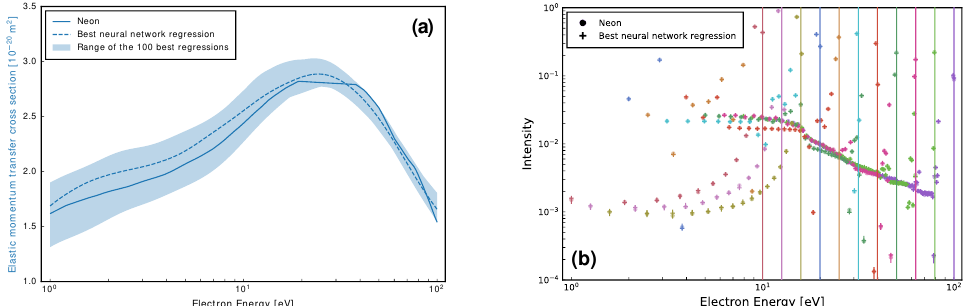
Figure 3. Neural network regression of Ne’s elastic MTCS [90], ( a ), and the corresponding agreement, ( b ), between its simulated EELS and the EELS used to perform the fit. The vertical lines in ( b ) denote the initial energies for each of the eleven EELS considered (from 10 eV to 100 eV incident energy, inclusive). Additionally, a shaded area in ( a ), along with vertical error bars in ( b ), are provided to indicate the range of the 100 best regressions. See also the figure legend for further details, noting that black is used to represent each colour of that marker shape and where colours correspond to each initial electron energies of 100, 79.43, 63.1, 50.12, 39.81, 31.62, 25.12, 19.95, 15.85, 12.59, and 10.0 eV, indicated by vertical lines. In this model, a bias vector size of 64 was used, along with 250,000 iterations.